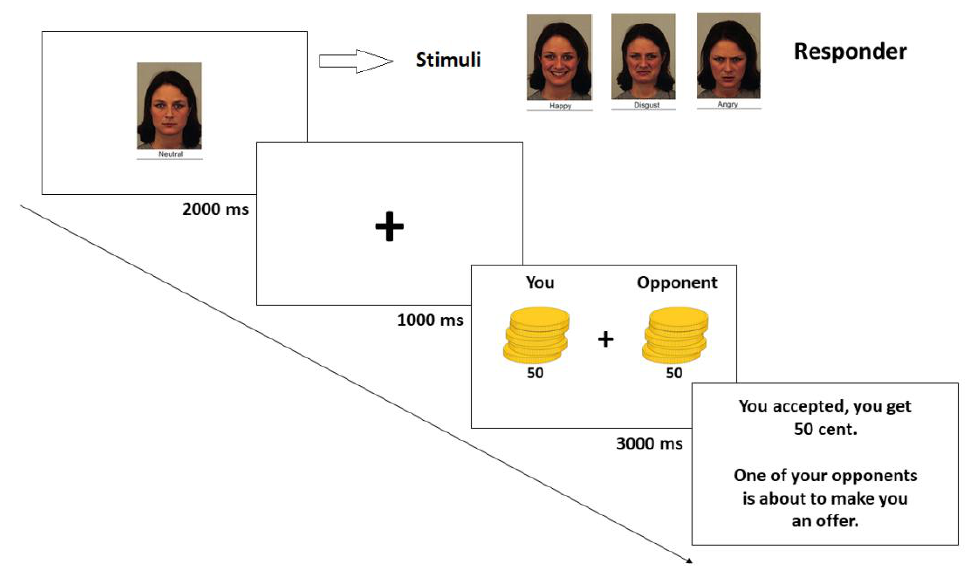
Figure 1. Task timeline for the ultimatum game in the r esponder’s experiment.